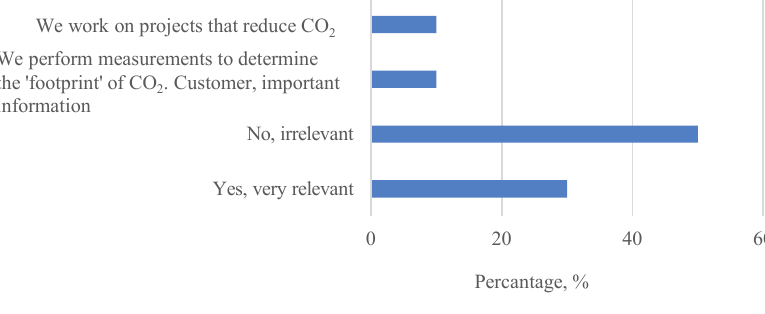
Fig. 9. Entrepreneur’s field of